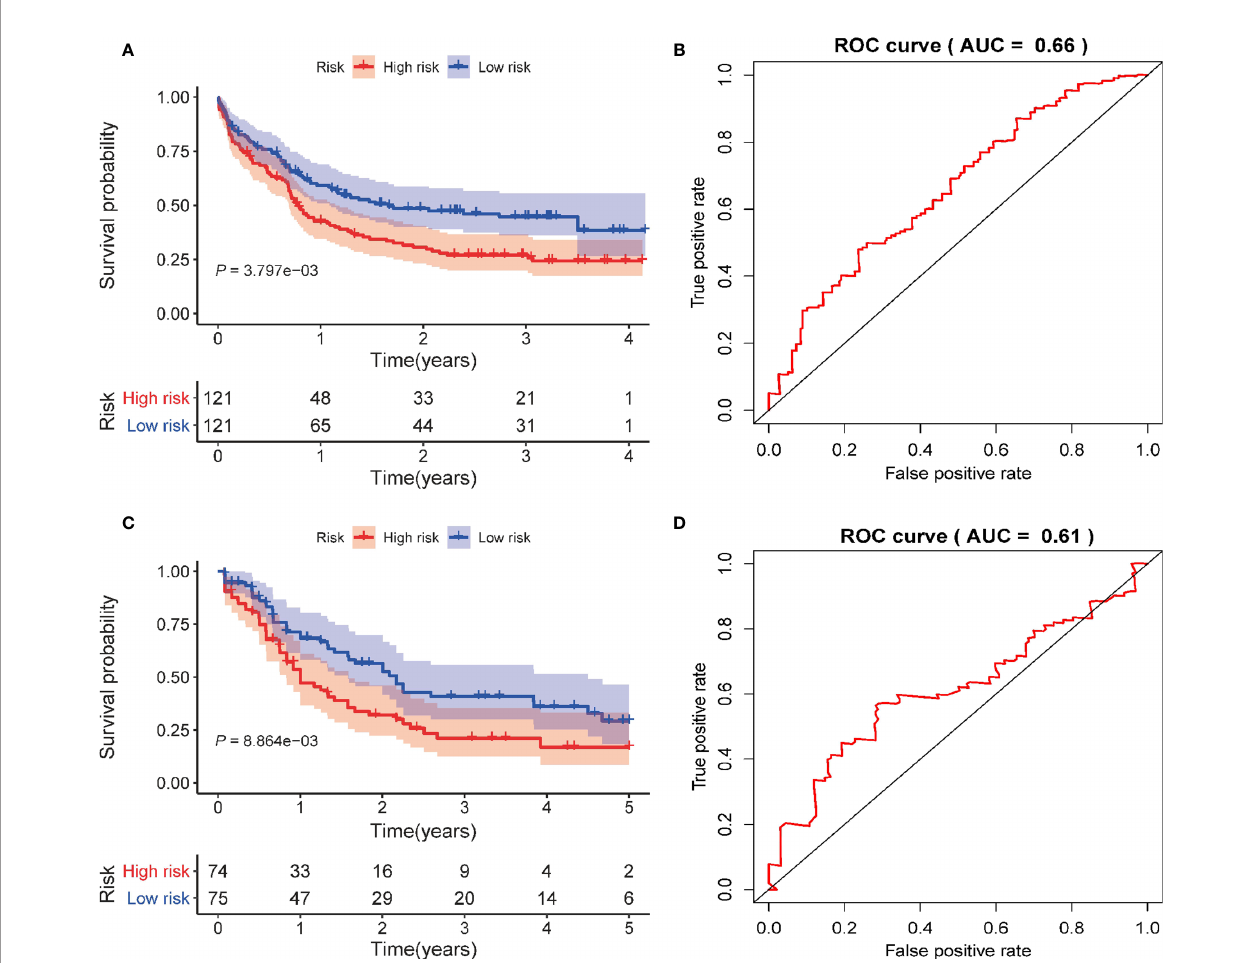
FIGURE 4 | Validation of the autophagy-related prognostic signature on external AML cohorts. (A) Kaplan – Meier curve of the prognostic signature in the GSE12417 cohort. (B) The AUC curve of the signature for 3 years in the GSE12417 cohort. (C) Kaplan – Meier curve of the prognostic model in the TCGA cohort. (D) The AUC curve of the signature for 3 years in the TCGA